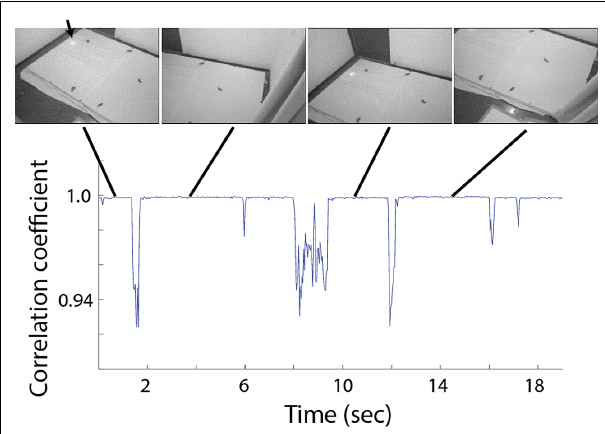
FIGURE 2 | Correlation between adjacent frames during 19 s of typical visual search behavior. Four video frames extracted from periods of fixation are shown above. Each shows a different view of the experimental arena and the scattered food items.The arrow points to the position of the loudspeaker, visible via the infra-red light source attached to it.